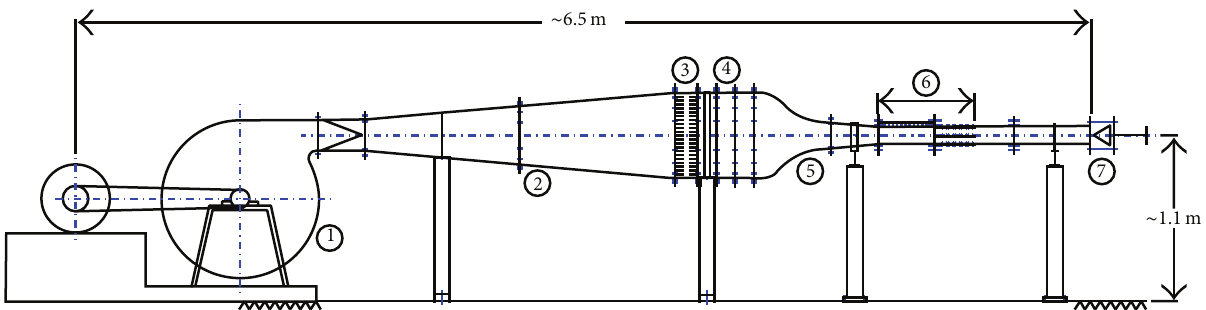
Figure 2: Layout of the test facility; the major components are numbered and are (1) centrifugal blower, (2) diffuser, (3) honeycomb, (4) screens, (5) contraction, (6) test section, and (7) exit